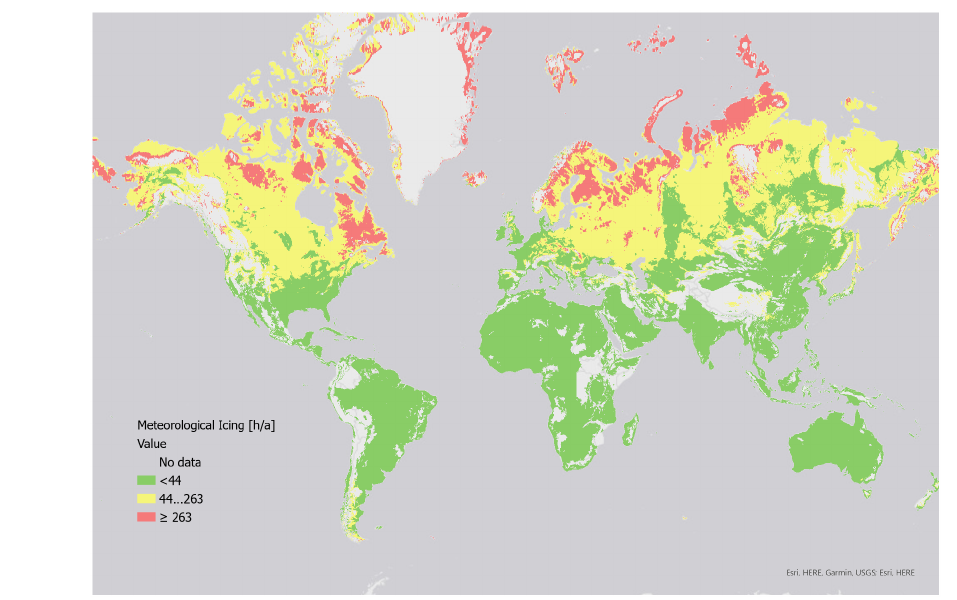
Figure 2. The Technical Research Centre of Finland (VTT) Wind Power Icing Atlas (WIceAtlas), showing the number of hours per year of meteorological icing. IEA Wind Task 19 considers areas with more than 44h of meteorological icing to be in an icing climate, which is a subset of cold climate. An interactive version of the map is available at http://virtual.vtt.fi/virtual/wiceatla/ (last access: 1 October 2022). Table 1. Challenges and R&D needs for site prospecting for wind energy in complex locations. Each need is associated with a qualitative estimate of the impact on project risk (high, medium, or low), including performance risk; the impact on the project’s LCOE (high, medium, or low); and the relevance, which is the approximate proportion of complex locations for which this would be applicable (all sites, most sites, some sites, few sites). Different fonts are used for easier overview. Bold fonts indicate high impact or highest frequency, italic fonts indicate medium risk or moderate frequency, and normal fonts indicate the least impact or lowest frequency. Situations where these are not applicable are indicated with